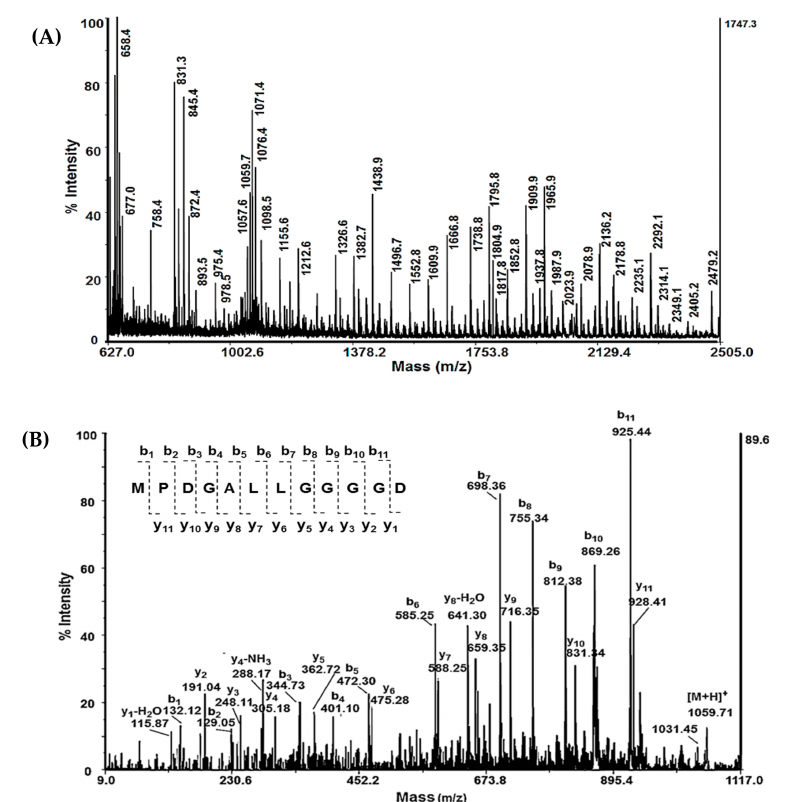
Figure 1. Mass spectrometric analysis of peptide fraction with Mw < 3 kDa by AutoflexTM III, High Performance MALDI-TOF&TOF / TOF Systems (Bruker Daltonics, Bremen, Germany): ( A ) MALDI- MS spectrum; ( B ) MALDI-MS / MS spectrum of peptide [M + H] + at m / z 1059.71